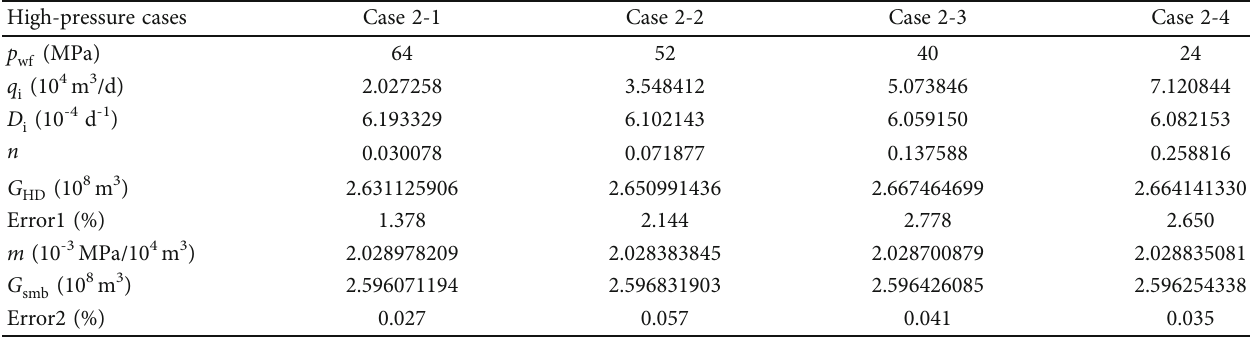
(a) The analysis results of the decline parameter method for numerical cases with high pressure High-pressure cases